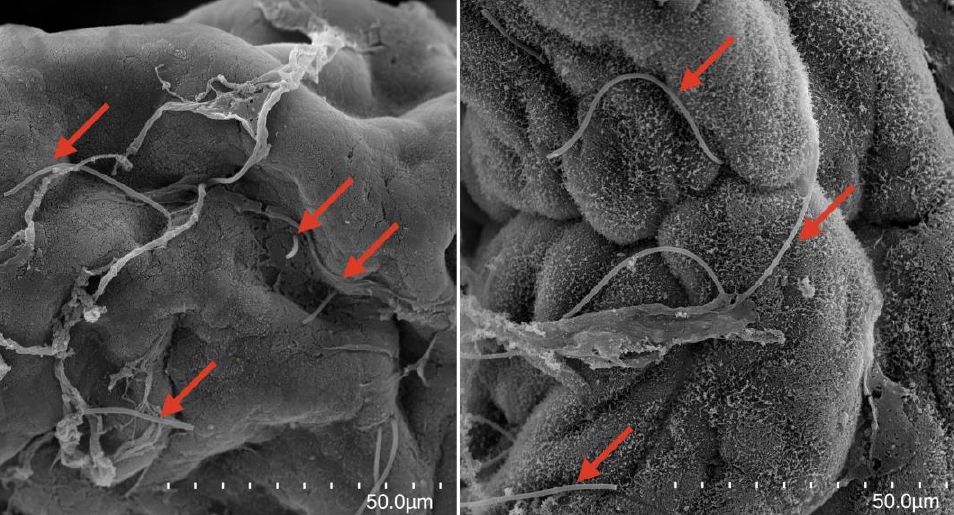
Figure 3. Scanning electron microscopy (SEM) showing the presence of segmented filamentous bacteria (SFB, in red arrows), probably Candidatus Arthromitus, associated to the epithelial cells in palm ruff intestines.